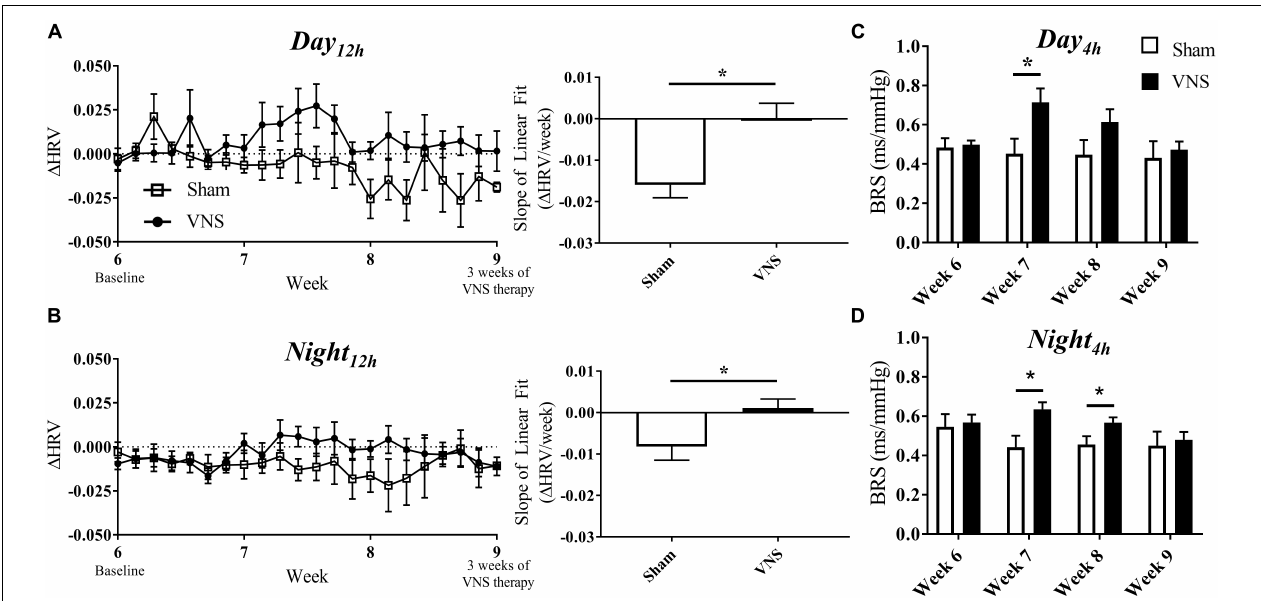
FIGURE 5 | Relative changes in HRV ( (cid:49) HRV) as HTN progresses. (cid:49) HRV as a function of time and slopes of the linear regressions are shown for Sham and VNS rats during the (A) Day 12h interval and (B) Night 12h intervals. BRS was quantified during the Day 4h (C) and Night 4h (D) intervals for Week 6 through Week 9. ∗ Indicates statistical significance between Sham and VNS